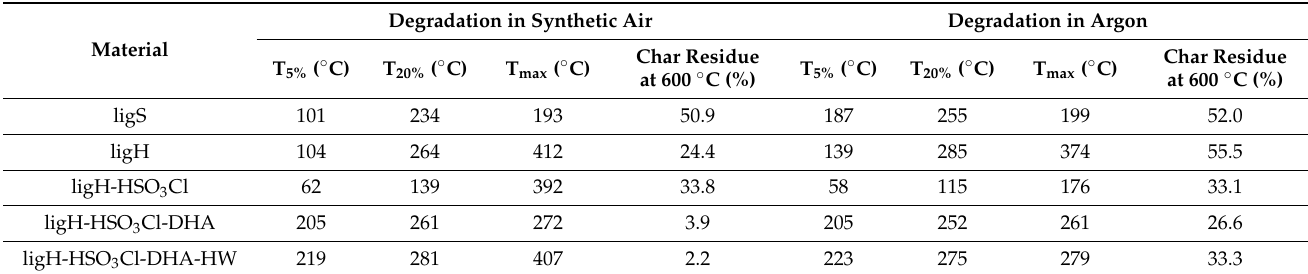
Table 2. Parameters of the thermal decomposition of the lignin-based